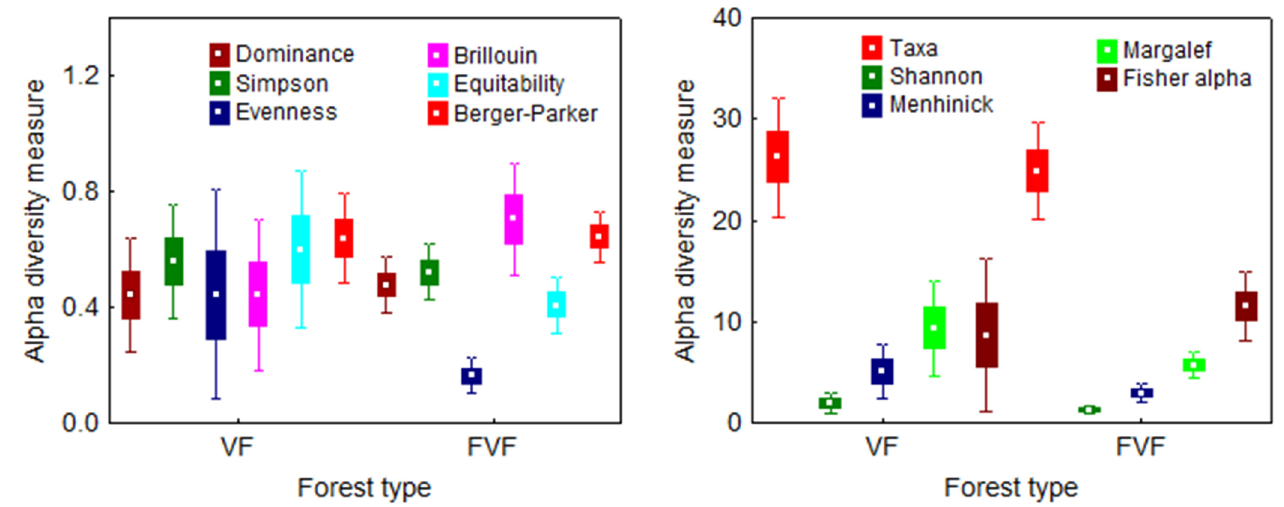
Figure 7. Ground vegetation diversity comparison between a virgin forest (VF) and former virgin forest (FVF). Alpha diversity measures: dominance, Simpson, evenness, Brillouin, equitability, Berger–Parker, taxa (richness), Shannon, Menhinick, Margalef and Fisher’s alpha index. Boxes: means ± standard errors of the mean, whiskers: 95% con fi dence intervals.